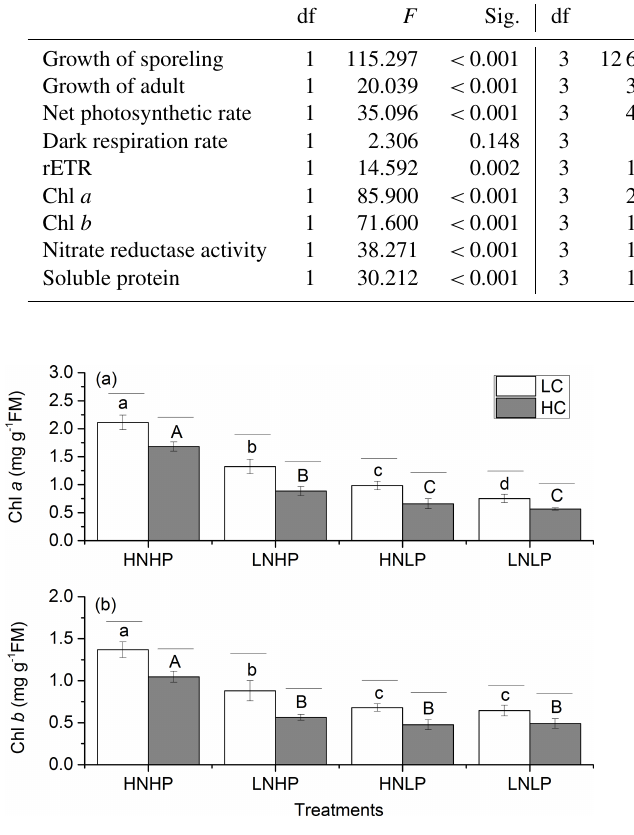
Figure 5. Content of Chl a (a) and Chl b (b) in adult U. linza grown under various conditions. LC, 400µatm; HC, 1000µatm; LN, 6.1µmolL − 1 ; LP, 0.2µmolL − 1 ; HN, 106.1µmolL − 1 ; HP, 10.2µmolL − 1 . The error bars indicate the standard deviations ( n = 3). Different letters (lower case for LC and capital for HC) above the error bars represent significant differences ( P < 0.05) among nu- trient treatments while horizontal bars represent significant differ- ences ( P < 0.05) between LC and HC within a nutrient treatment.